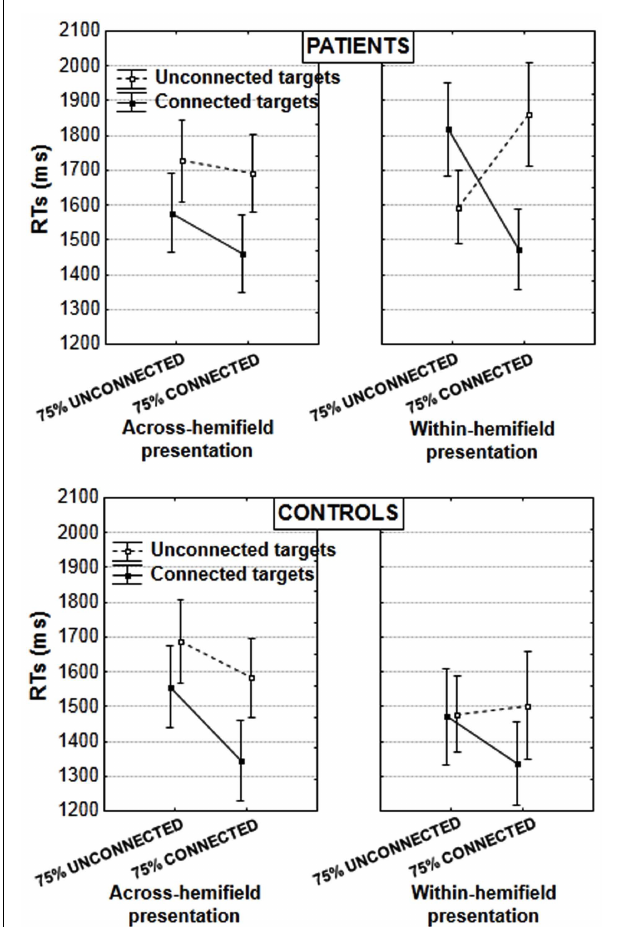
FIGURE 3 | Mean RTs in the induction blocks, in patients (upper panel) and controls (lower panel; vertical bars: error bars). Results are illustrated according to the experimental blocks (with a bias toward unconnected vs. connected figures), type of target pair (unconnected vs. connected), and presentation of target pair (in the same or in different